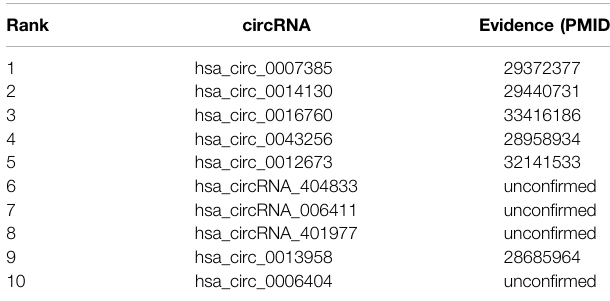
TABLE 2 | Top 10 candidate circRNAs related to lung